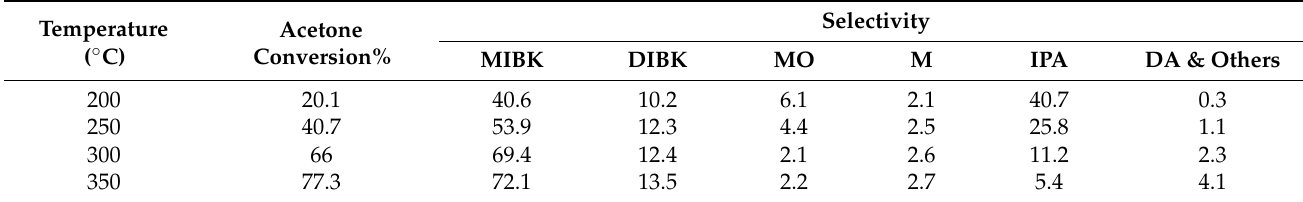
Table 1. The conversion and selectivity of the MIBK process at different temperatures